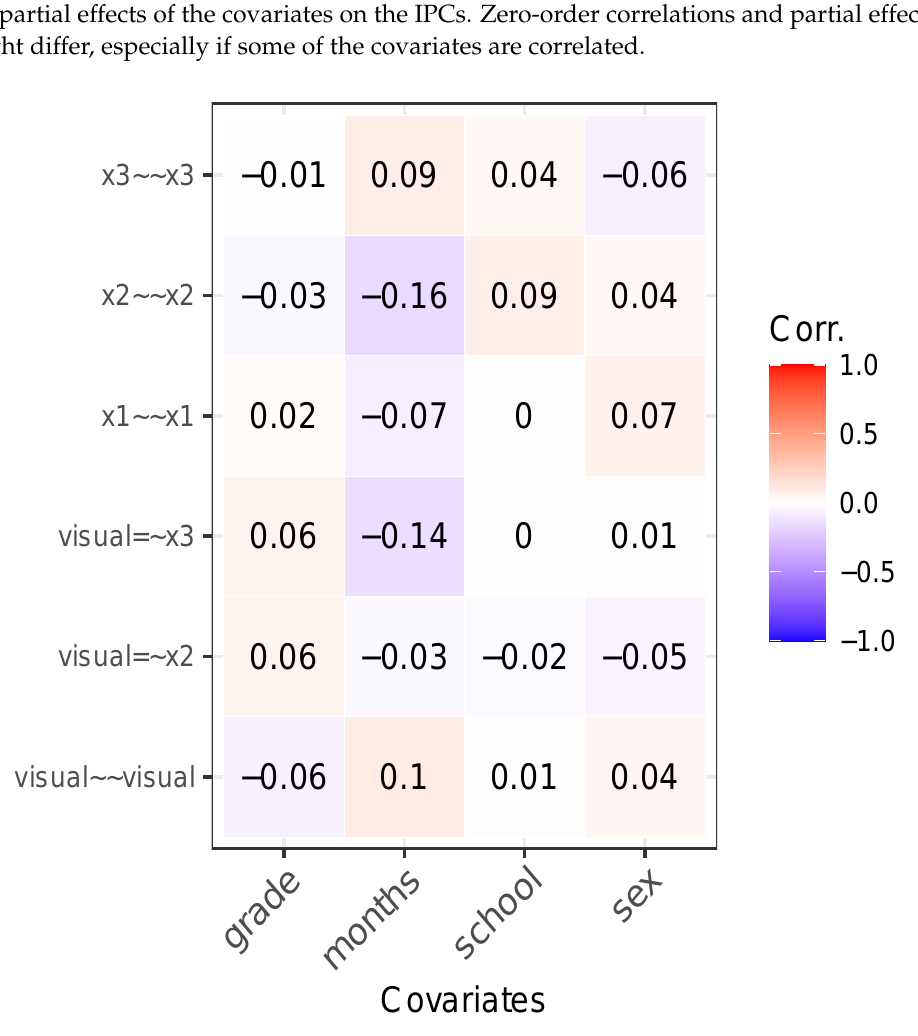
Figure 3. Correlations between covariates (x-axis) and the IPCs of the model parameters (y-axis) obtained with plot(ipcr_visual, print_corr = TRUE). Parameter names are given in lavaan